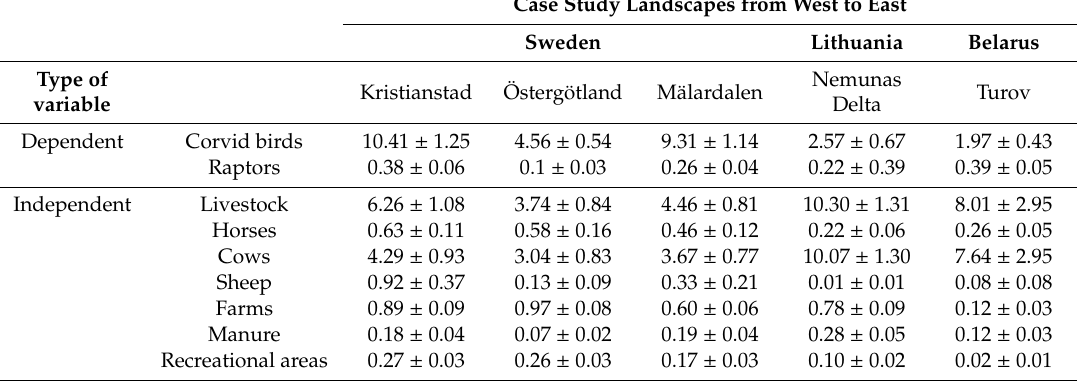
Table 3. Mean number of observations with standard error ( ± ) of dependent and independent variables at the point scale level (i.e., at each 1-km 2 cell) within the five case study landscapes in the Baltic Sea Region.